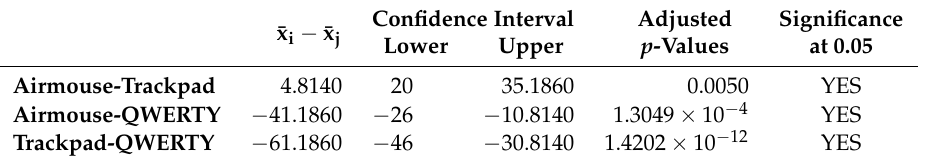
Table 8. Dunn & Sidak Post-Hoc Analysis for Task5.